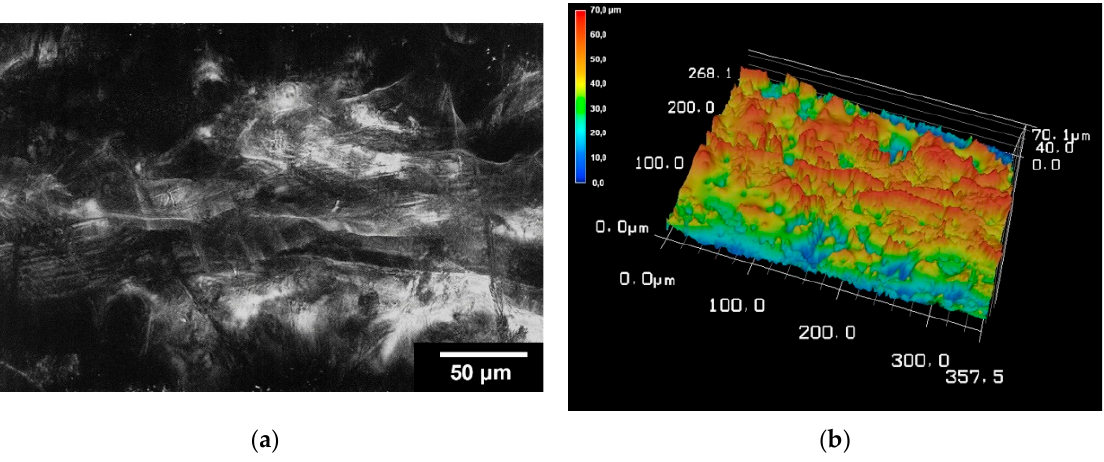
Figure 5. Images of 3D laser scanning of the scaffold surface ( a ); image of 3D reconstruction of the scaffold surface ( b ). The images were taken with KEYENCE VK-X210 3D laserscanning microscope; 200× magnification; scale bar = 4 mm.